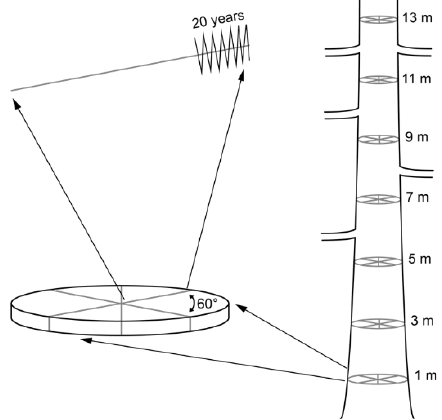
Figure 1. Schematic drawing illustrating the sampling design of a 360-year old Larix decidua in the Simplon Valley including seven discs in heights ranging from 1 to 13 m, six radii every 60° on each disc, and 20 tree-rings from 1991 – 2010 on each radius.